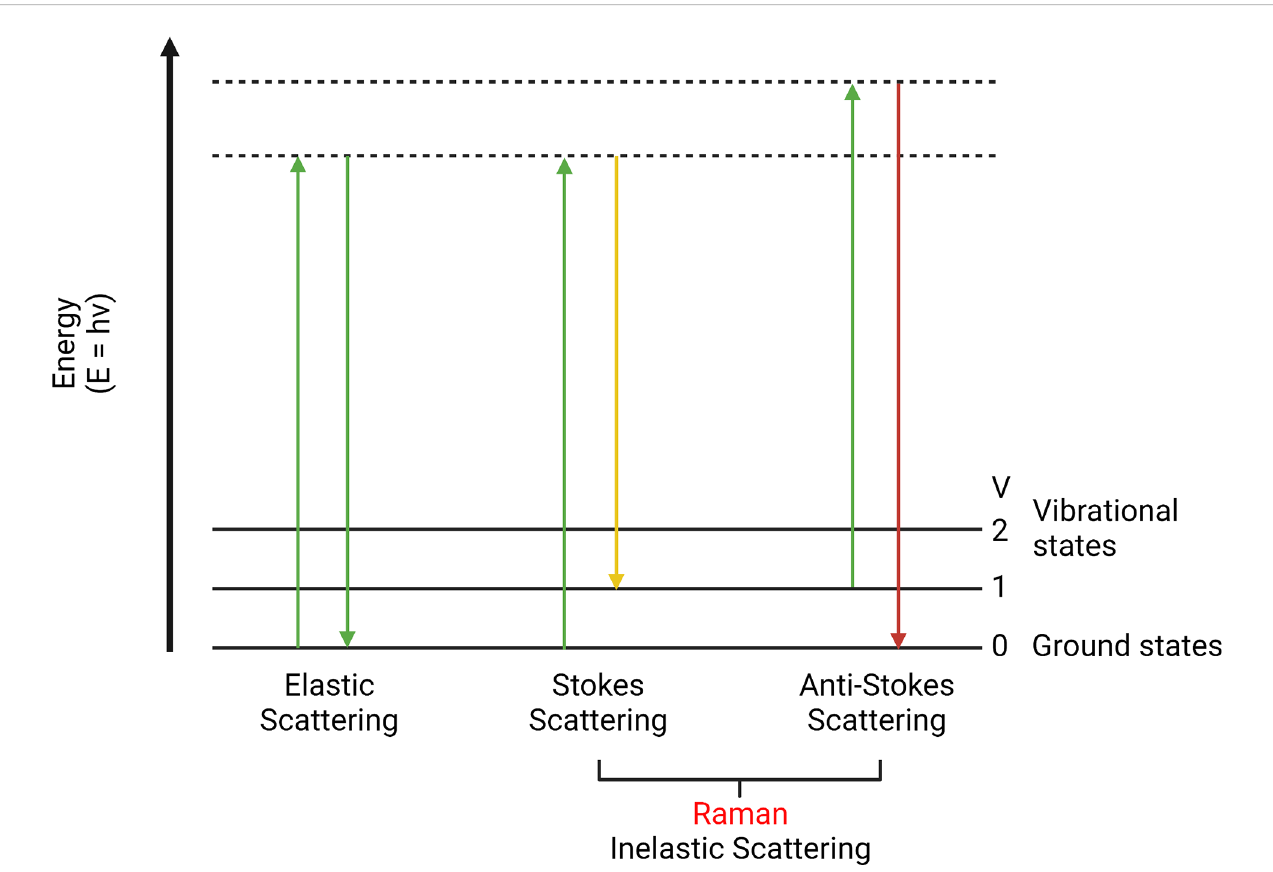
FIGURE 1 Elastic scattering, Stokes, and anti-Stokes Raman scattering. This is a scattering energy level diagram (molecular energy states). Stokes scattering leads to an energy shift from incident photons to chemical bonds. Anti-Stokes scattering moves vibrational excited chemical bonds to the incident